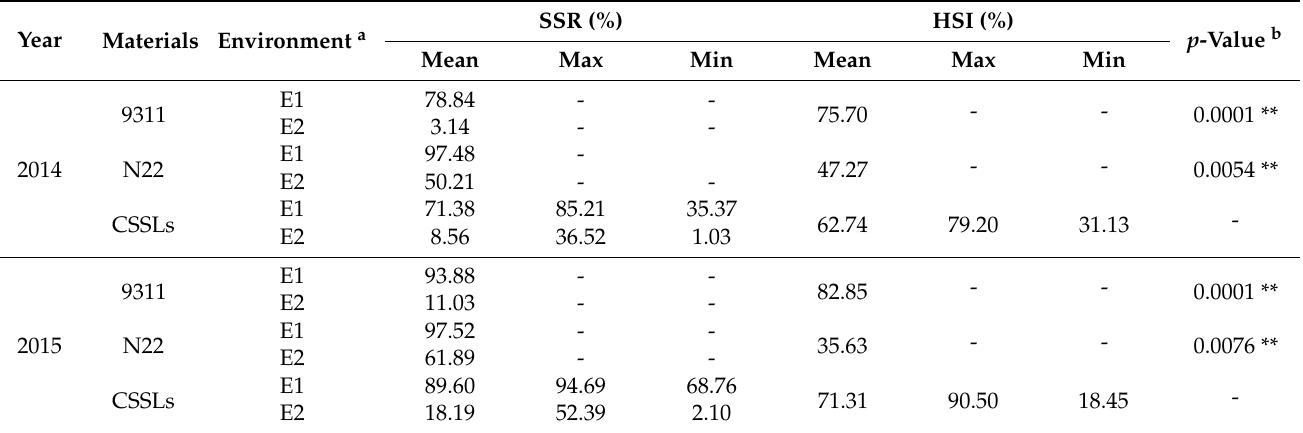
Table 3. Phenotype data of seed-setting rate of rice under natural and high temperature for CSSLs and parents (9311 and N22) across two environments.